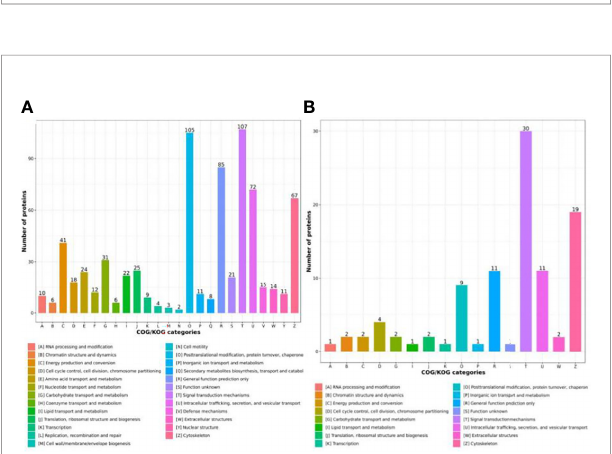
FIGURE 2 | Enrichment analysis of phosphorylated protein motifs (A) . Heatmap of the amino acid compositions of the phosphorylation sites showing the frequency of the different types of amino acids around serine (B) and threonine (C) . Red indicates signi fi cant enrichment of the amino acid near the modi fi cation site, and green indicates signi fi cant reduction of the amino acid near the modi fi cation site.